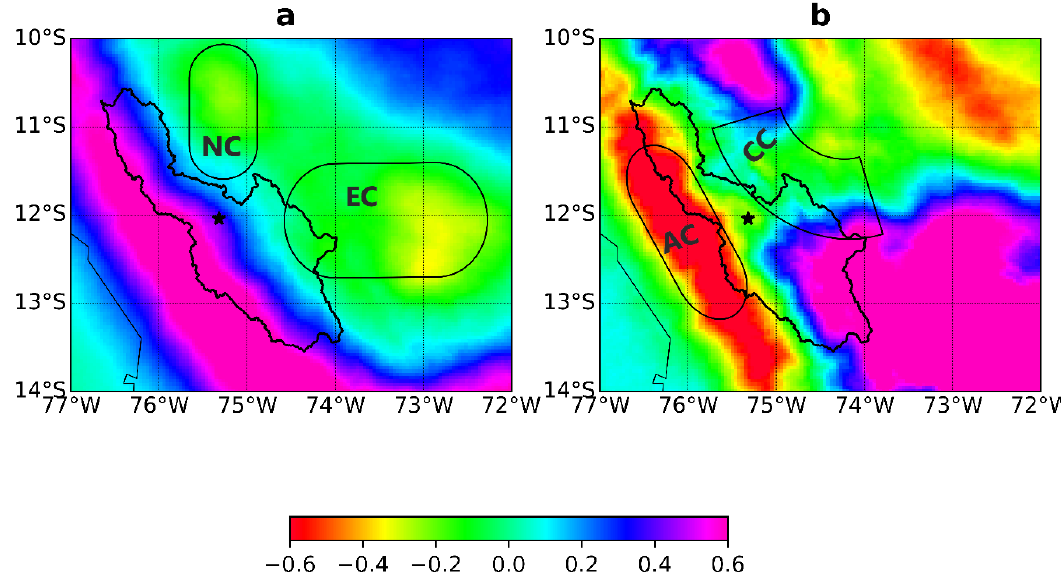
Figure 15. EOFs of cloud brightness temperature from GOES13 data for austral summer (December–January–November) during 2010–2017, ( a ) first mode with 77.75% and ( b ) second mode with 13.29%.NC: Northern convection. EC: Eastern Cloudiness. AC: Andes Cloudiness. North-East cloudiness (CC).